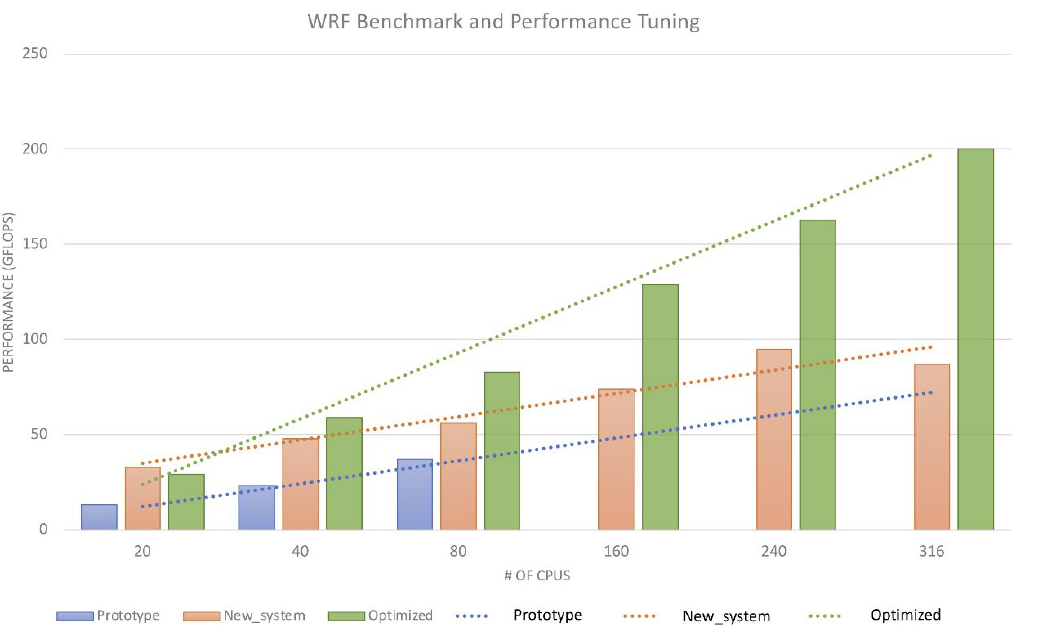
Figure 6. Comparison of WRF system performance in Gflops with various core counts. Blue, PW; orange, RPW; green, IRPW.